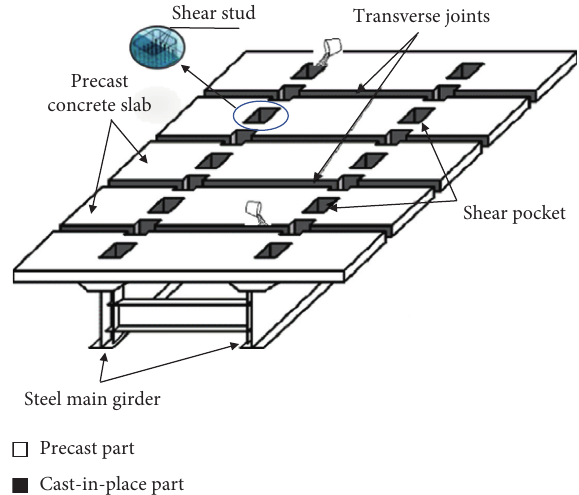
Figure 1: Twin I-girder composite bridge with the precast concrete